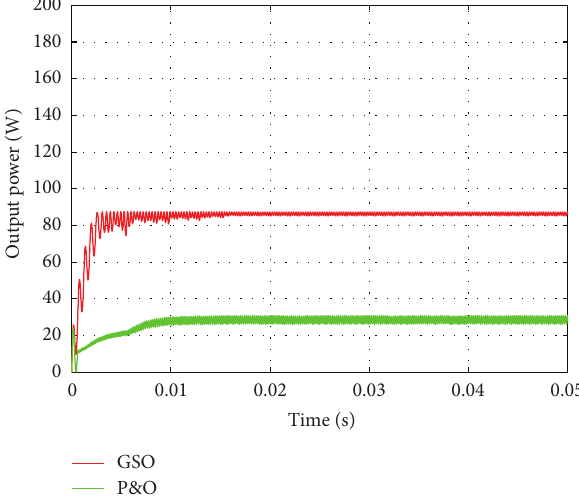
Figure 14: Output power of the PV module for the GSO method and P&O method under 300 W / m 2 , 25 ∘